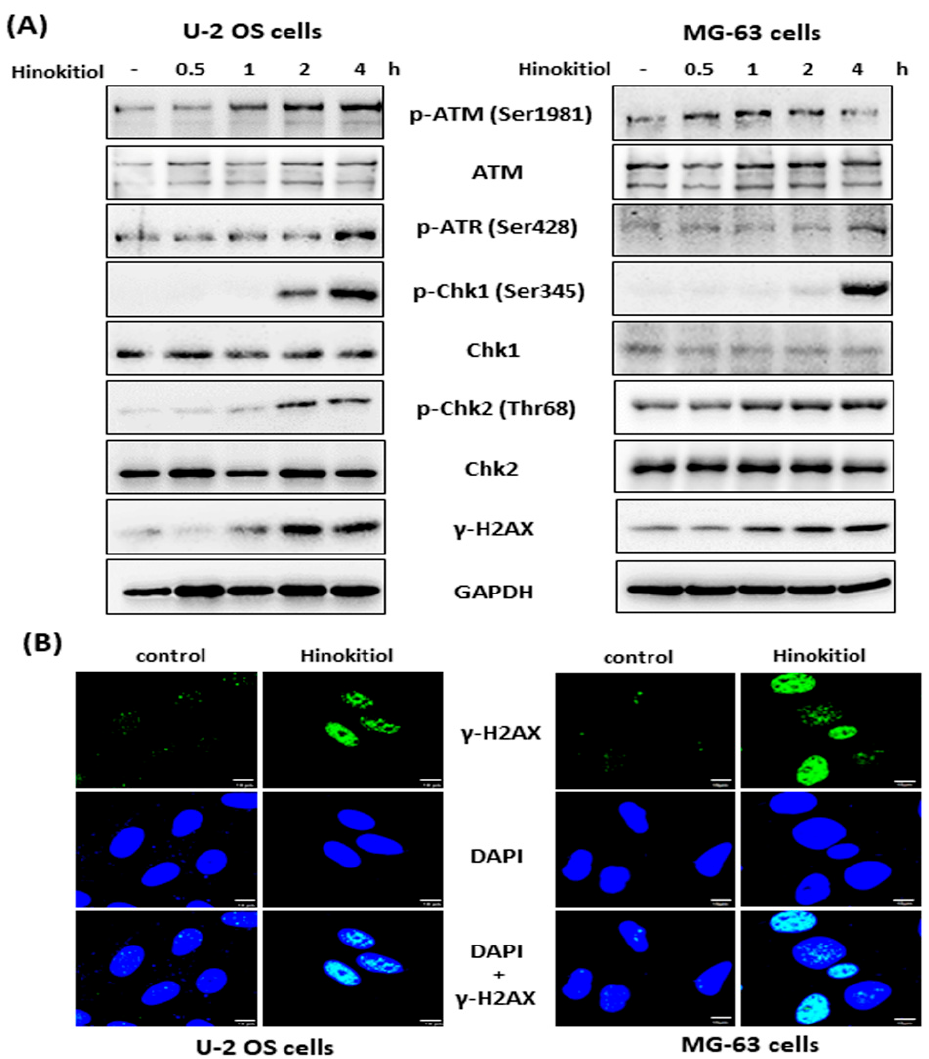
Figure 3. Hinokitiol induces a DNA damage response in osteosarcoma cell lines. U-2 OS or MG-63 cells were incubated with hinokitiol (40 µ M), and collected at the indicated time points. The phosphorylation level of ATM, ATR, Chk1, Chk2, and γ -H2AX were analyzed by Western blotting ( A ). ( B ) Hinokitiol induces γ -H2AX foci. U-2 OS or MG-63 cells were incubated with hinokitiol (40 µ M) for 4 h, and then the cells were immunostained for γ -H2AX and nuclei were counterstained with DAPI.